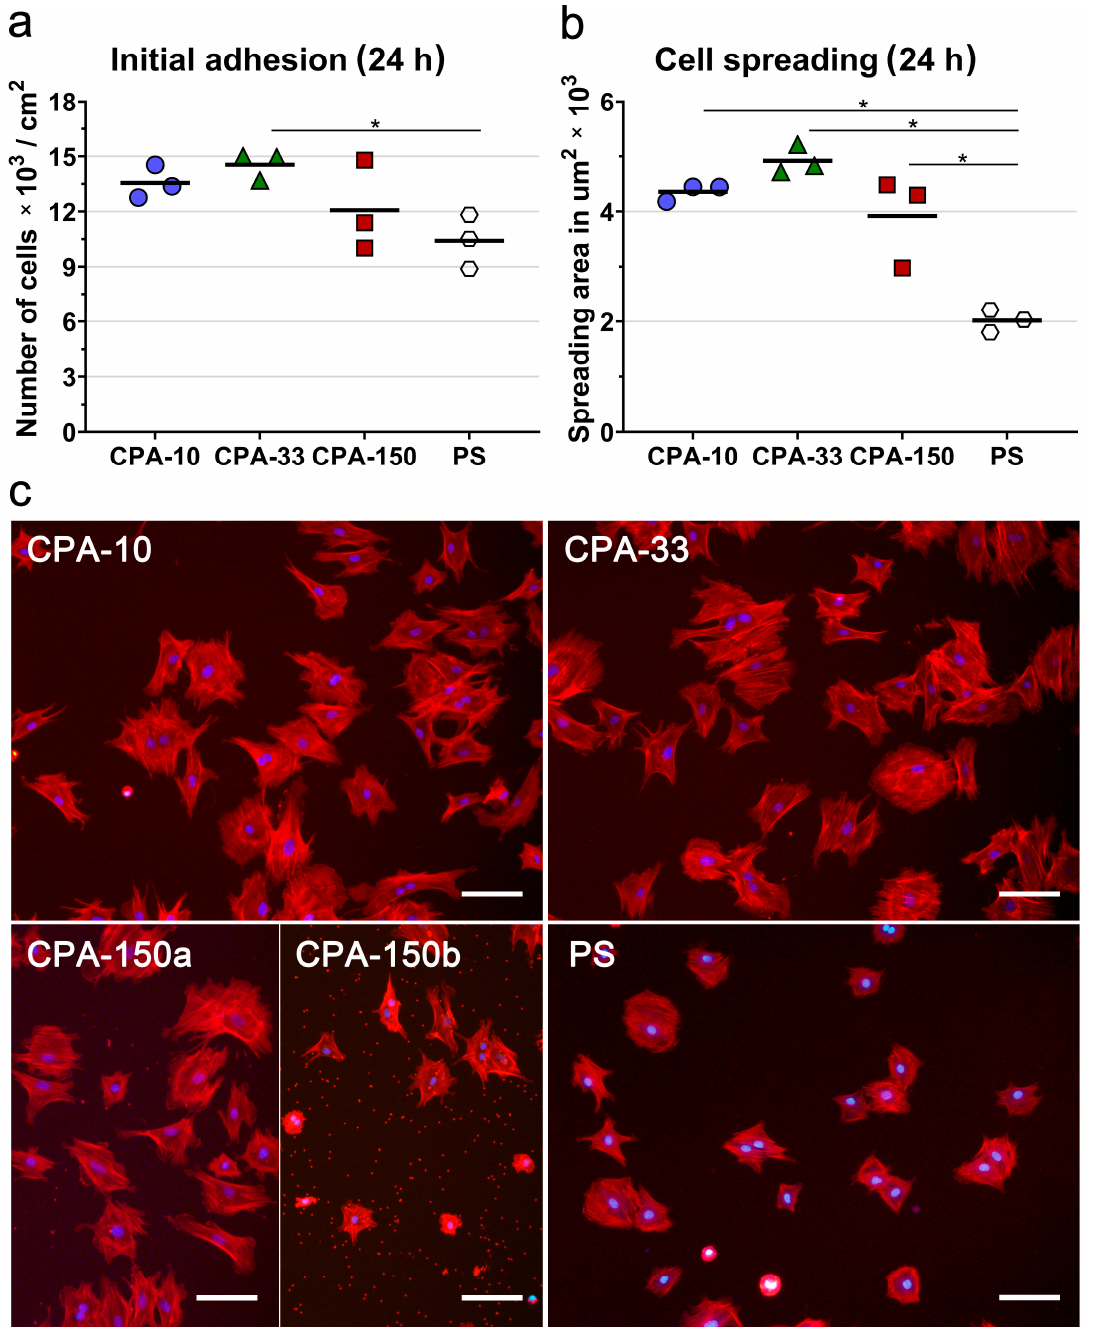
Figure 4. Initial adhesion of VSMCs on PS culture dishes coated with PP films deposited at the average RF power ( P av ) of 10, 33, and 150 W (labelled as CPA-10, CPA-33, and CPA-150, respectively): ( a ) number of adhered cells, ( b ) cell spreading areas, and ( c ) cell morphology 24 h after seeding. ( a , b ) The dots represent individual biological samples. Each dot depicts the arithmetic mean calculated ( a ) from cell numbers obtained from 15 pictures per each biological sample or ( b ) from spreading areas of a minimum of 120 cells per each biological sample. The bold central lines show the arithmetic mean of biological samples. Statistically significant differences ( p ≤ 0.05) are marked by horizontal lines with asterisks connecting the differing samples. ( c ) Microphotographs were taken by an epifluorescence Olympus IX-71 microscope. Cell nuclei are visualized by Hoechst #33258 (blue), while the cell membrane and the actin cytoskeleton are visualized by Phalloidin-TRITC (red). The scale bar depicts 100 μ m.